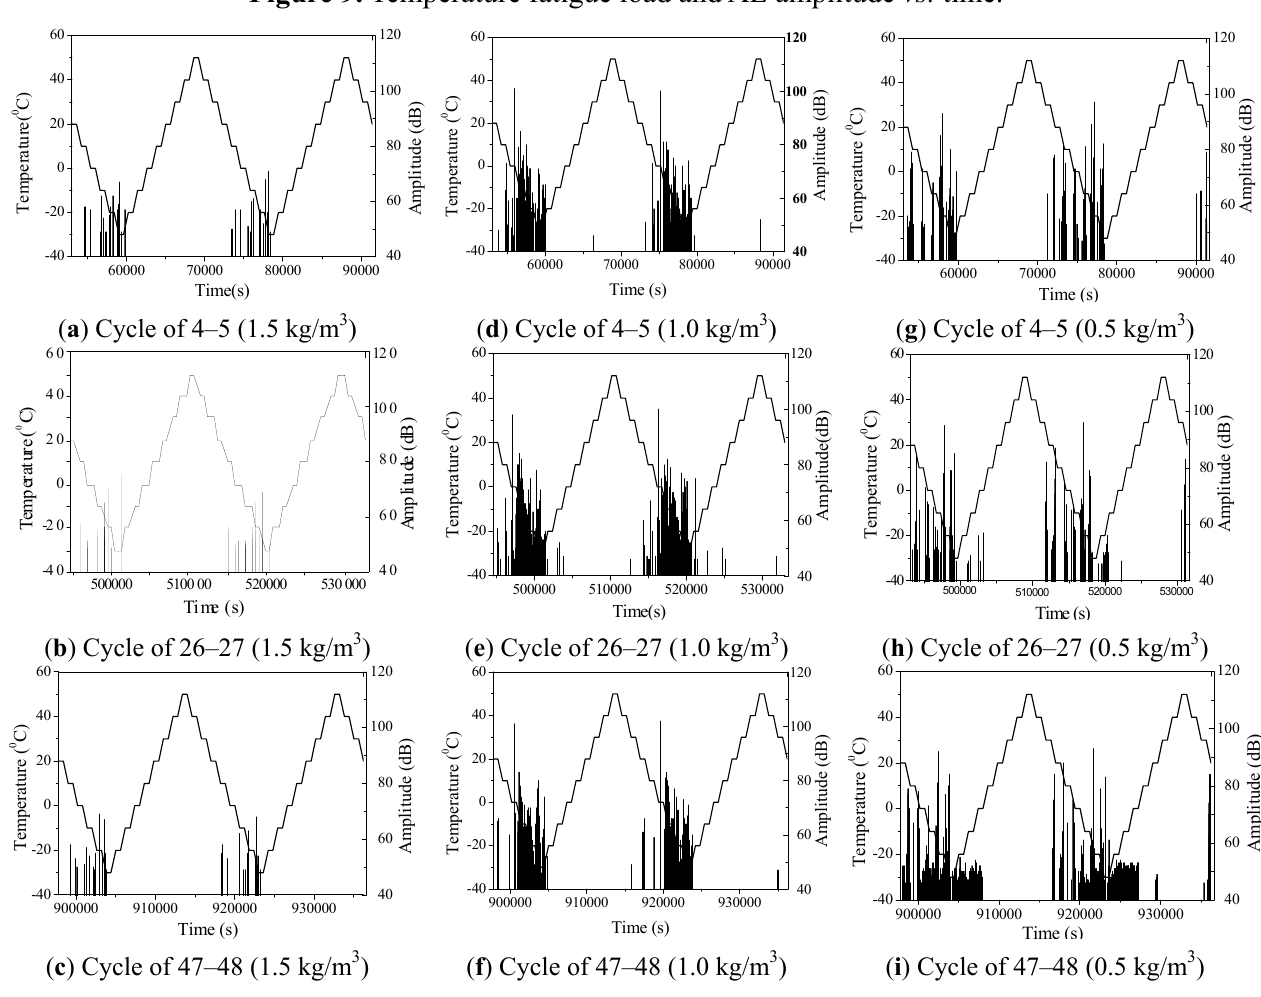
Figure 9. Temperature fatigue load and AE amplitude vs.